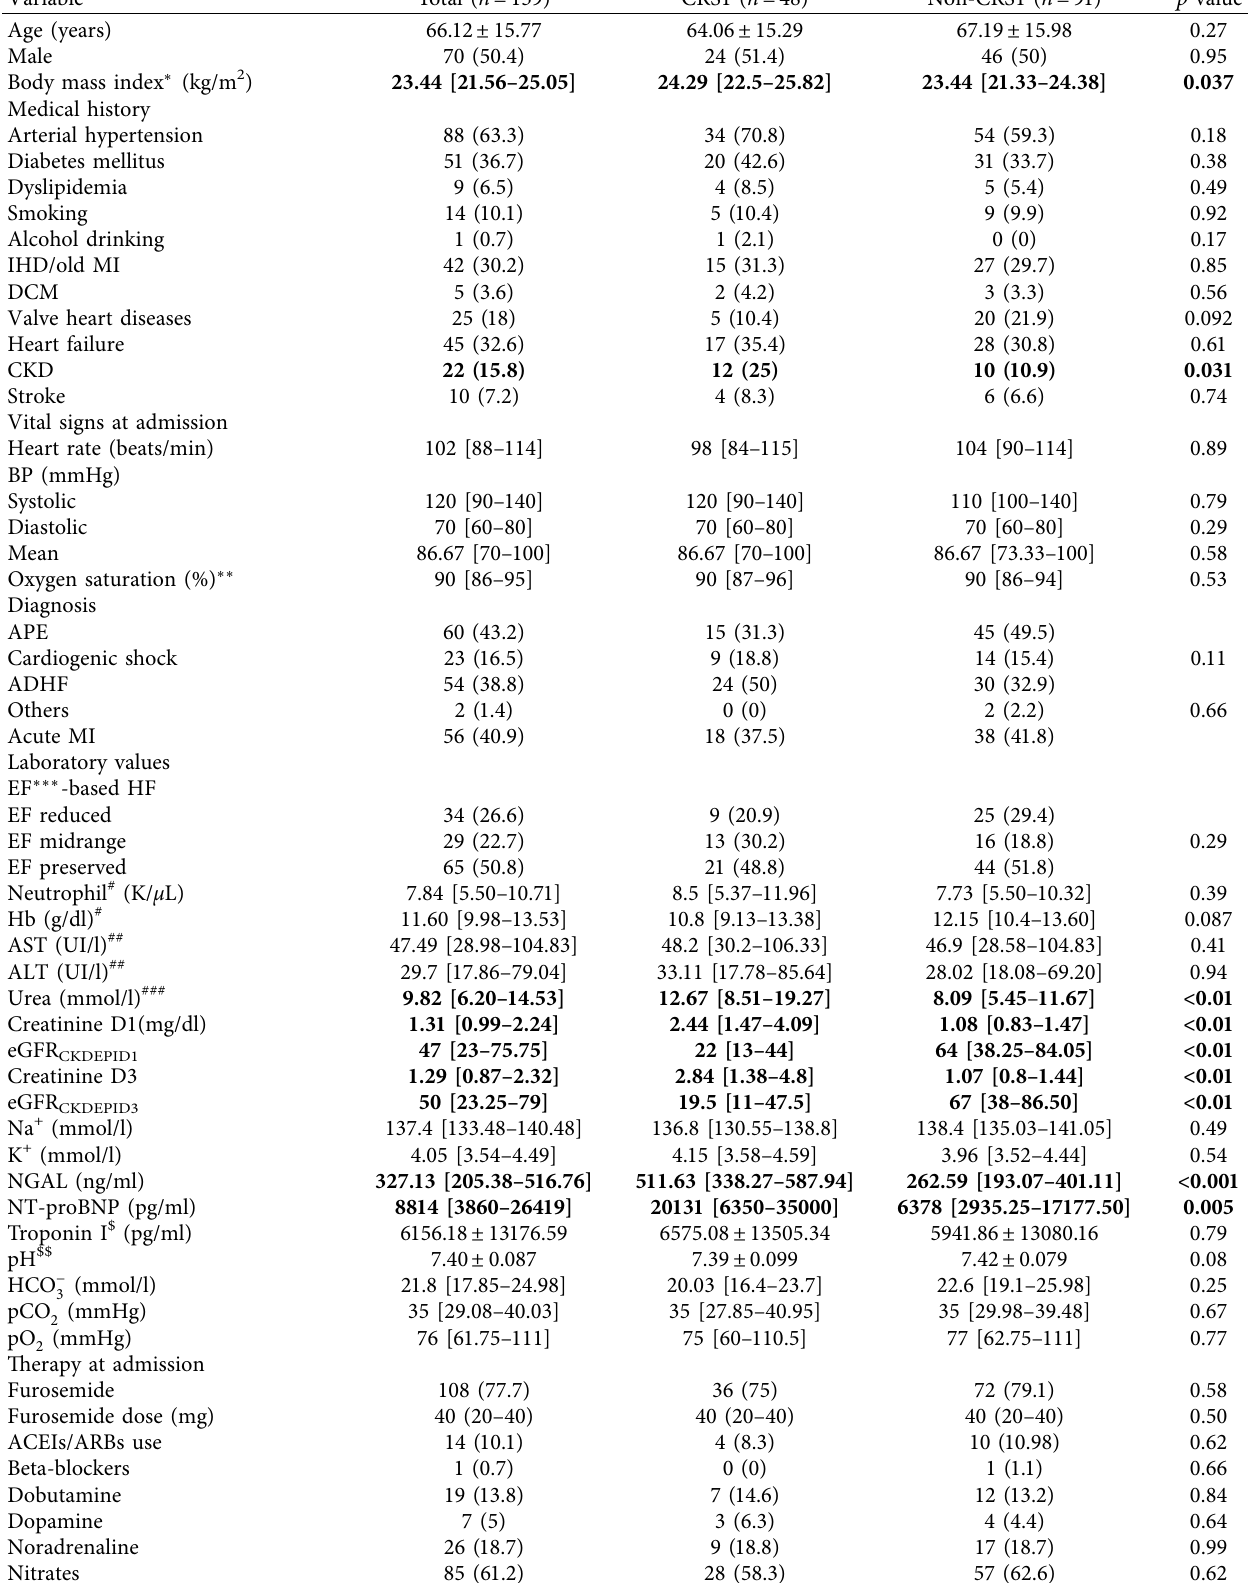
Table 1: Demographic and clinical